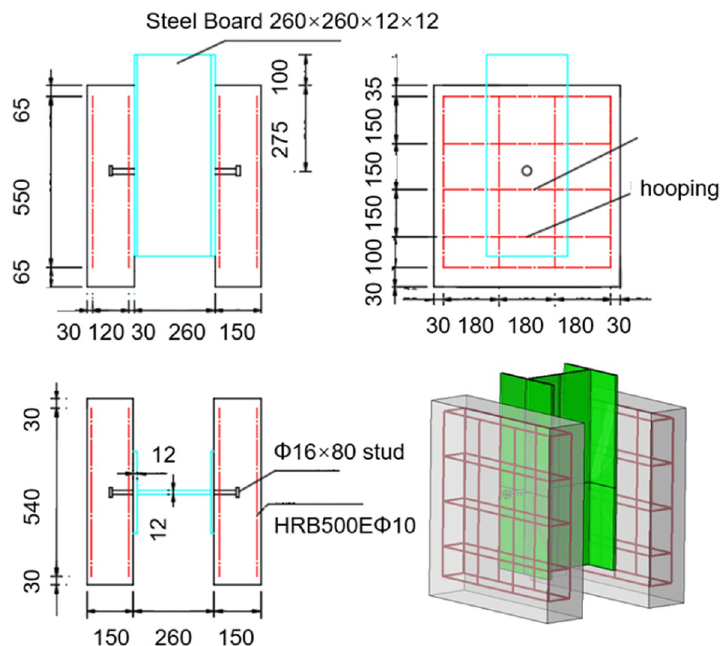
Fig. 4 Size of push-out specimen